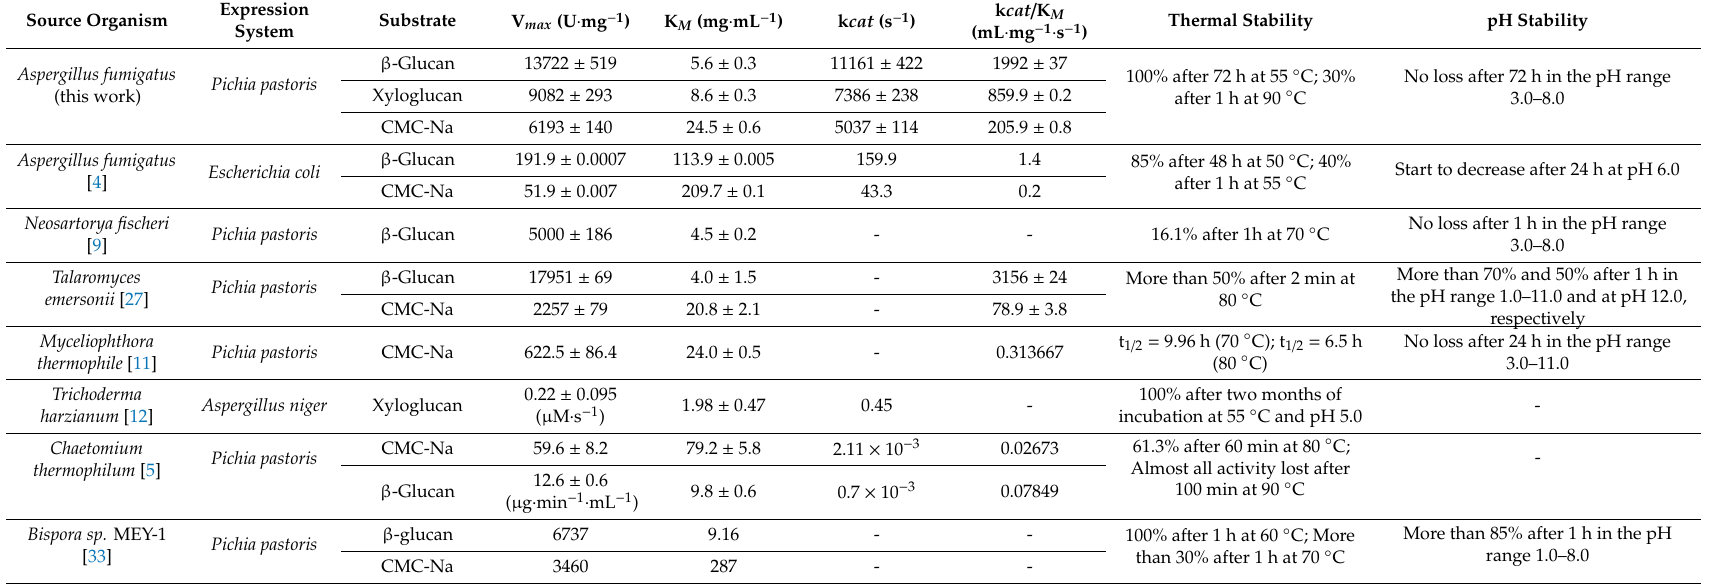
Table 3. Comparison among the catalytic and stability properties of GH7 endoglucanases from di ff erent